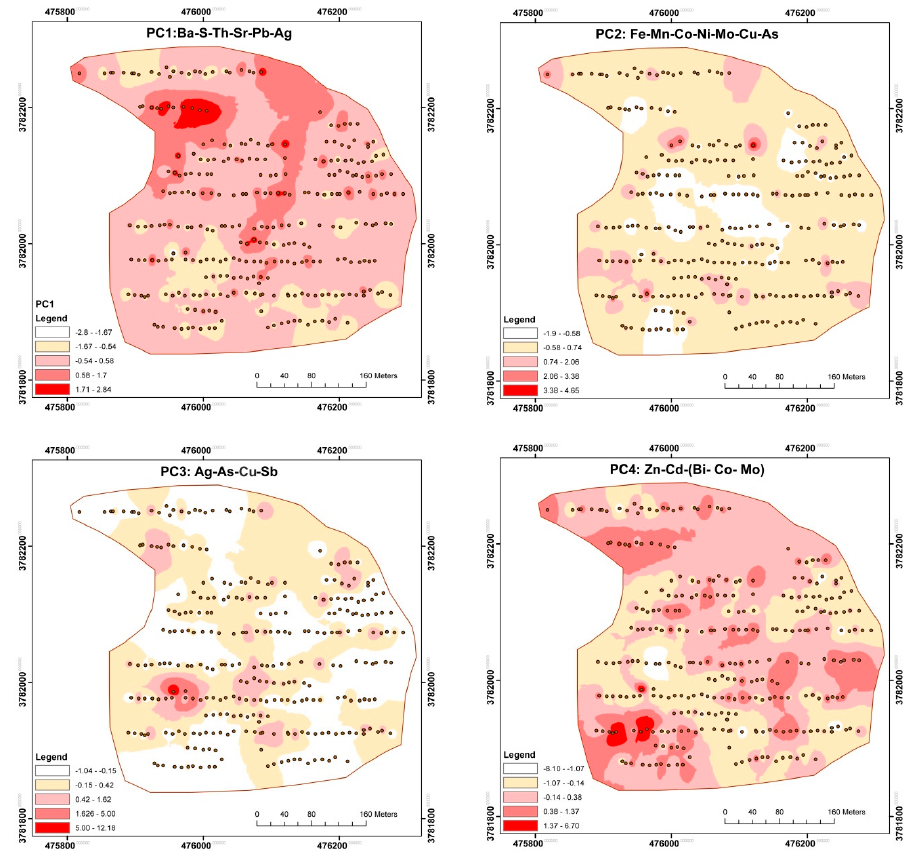
Figure 7. Spatial distribution of the varimax rotated PCs 1–4 of the surface samples in Block A of the Ravanj deposit. Table 5. Results of Robust PC analyses of tunnel samples (n = 42) from Block A of the Ravanj deposit (by using the broken-stick method, [45]). Significant values are shown in bold. Only PCs with eigenvalues>1 are displayed.